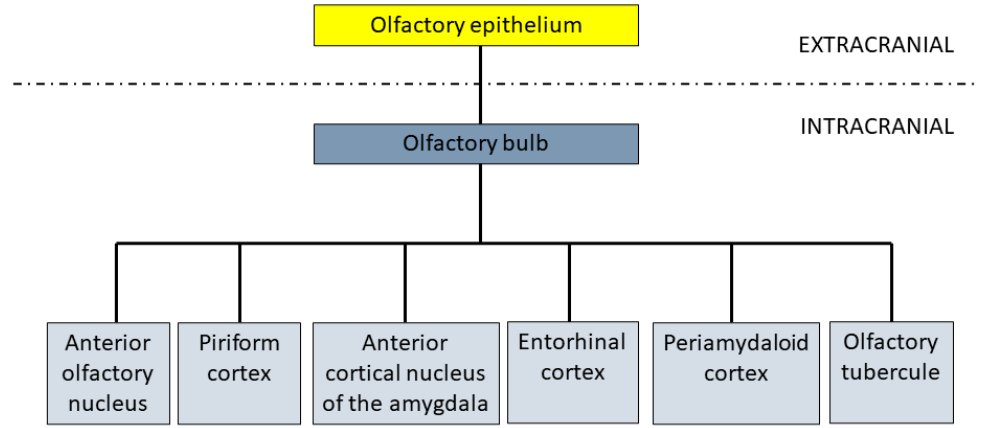
Figure 1. Schematic illustration of key olfactory pathways.